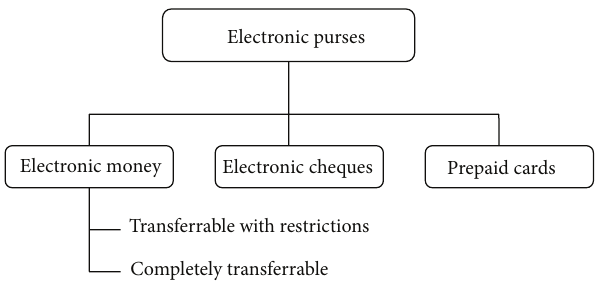
Figure 3: Classification of electronic purse systems based on smart